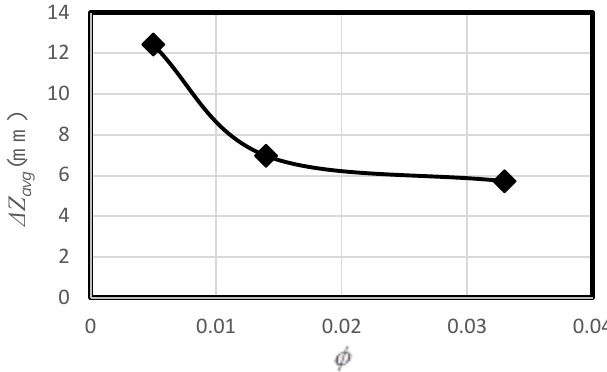
Figure 6. Variation of ∆ Z avg versus φ.